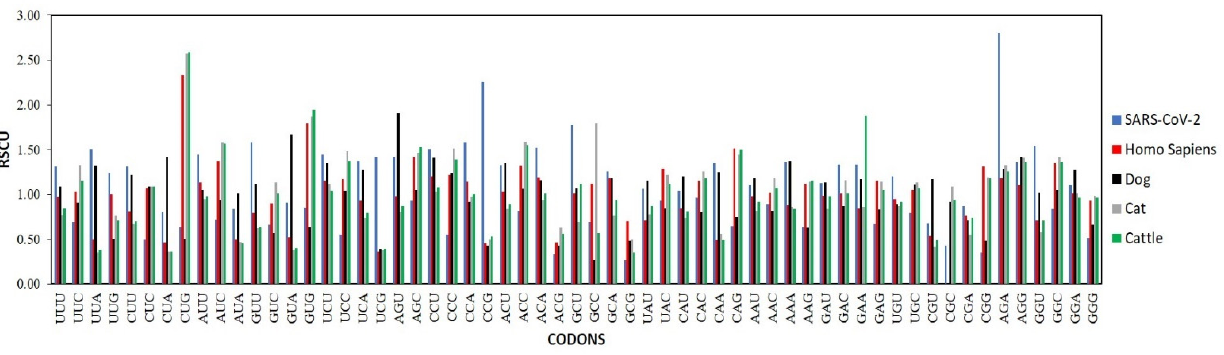
Figure 2. Comparisons of RSCU values of SARS-CoV-2 virus with its host humans, dog, cat, and cattle. The dog, cat, and cattle RSCU is shown as calculated by Dutta et al. [53].